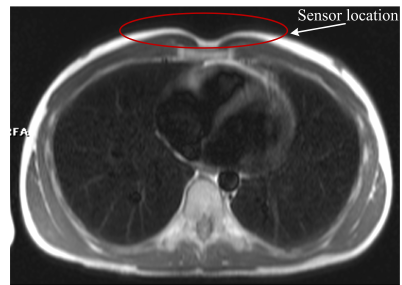
Figure 16. A sample MRI image (axial view) showing where the FBG sensor was positioned: A GE T2-weighted image (400 × 400